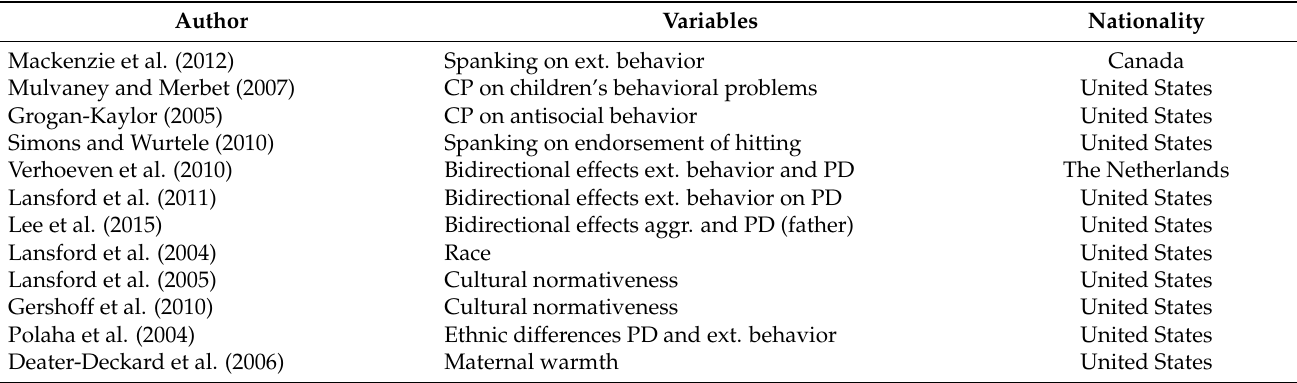
Table 1. Overview of